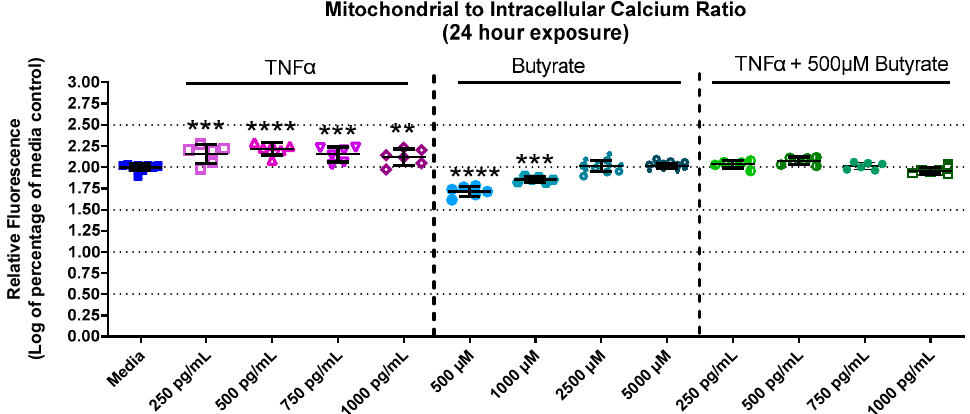
Figure 4. Mitochondrial and intracellular calcium after exposure to butyrate and TNF α at 24 h. Ratio of mitochondrial to intracellular calcium. Fluorescence intensity is graphed for each experimental group and is normalized to the medium control (mean relative fluorescence ± standard deviation). Asterisks indicate degree of significance from medium control (One-way ANOVA followed by a Dunnett’s multiple comparison test, n = 6/experiment; significance determined at ** = p < 0.01, *** = p < 0.001, **** = p < 0.0001).